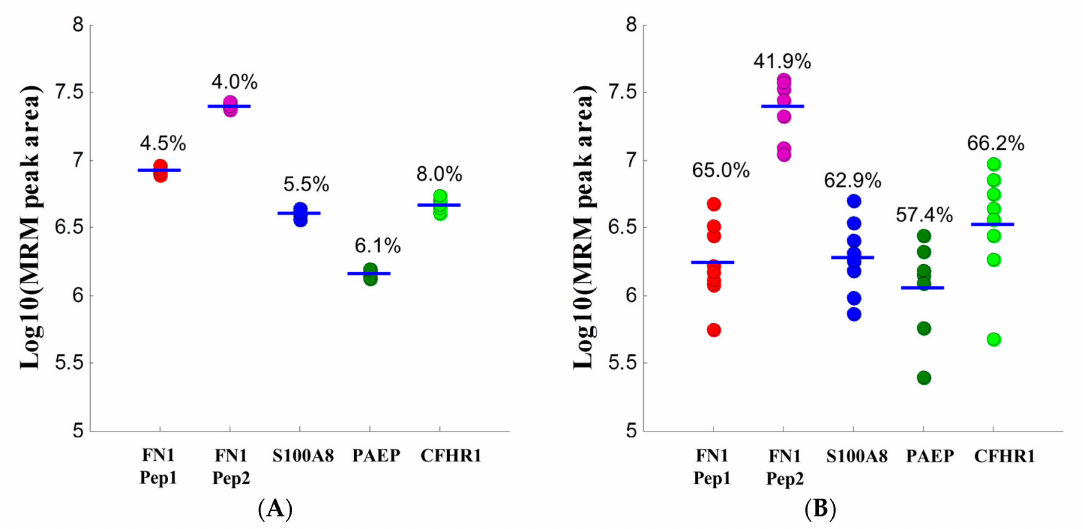
Figure 3. MRM peak area distribution for analyses of a pooled and eight individual serum samples. For FN-1, two peptides were quantitated (see Table 1 for protein names). Peptide 1 (Pep1) represents EESPLLIGQQSTVSDVPR and peptide 2 (Pep2) represents SYTITGLQPGTDYK, respectively. ( A ) Peak area distributions obtained in 10 replicate analyses of the pooled control sample with indicated observed CV for each; ( B ) Mean peak area distributions observed in three replicate analyses of each monitored peptide among eight individual healthy control samples. The numbers indicate the observed inter-individual